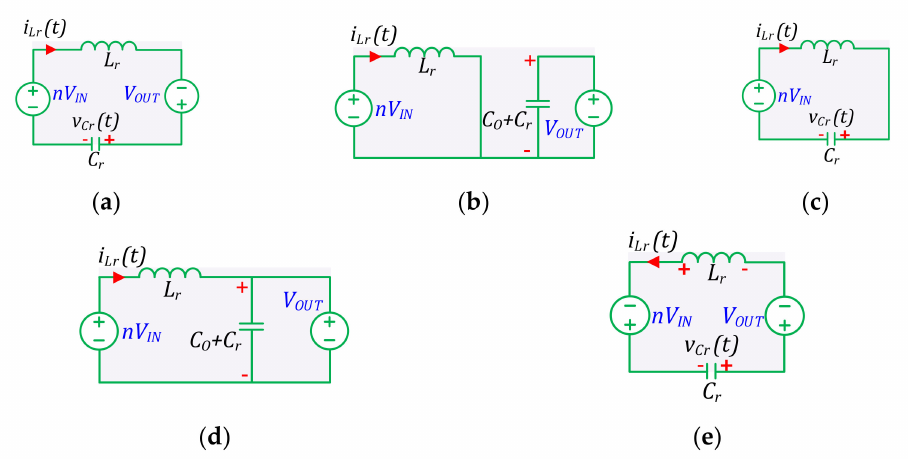
Figure 6. Equivalent circuits of the proposed converter in the boost - SRC conditions. ( a ) Mode I, ( b ) Mode II, ( c ) Mode III, ( d ) Mode IV, ( e ) Mode